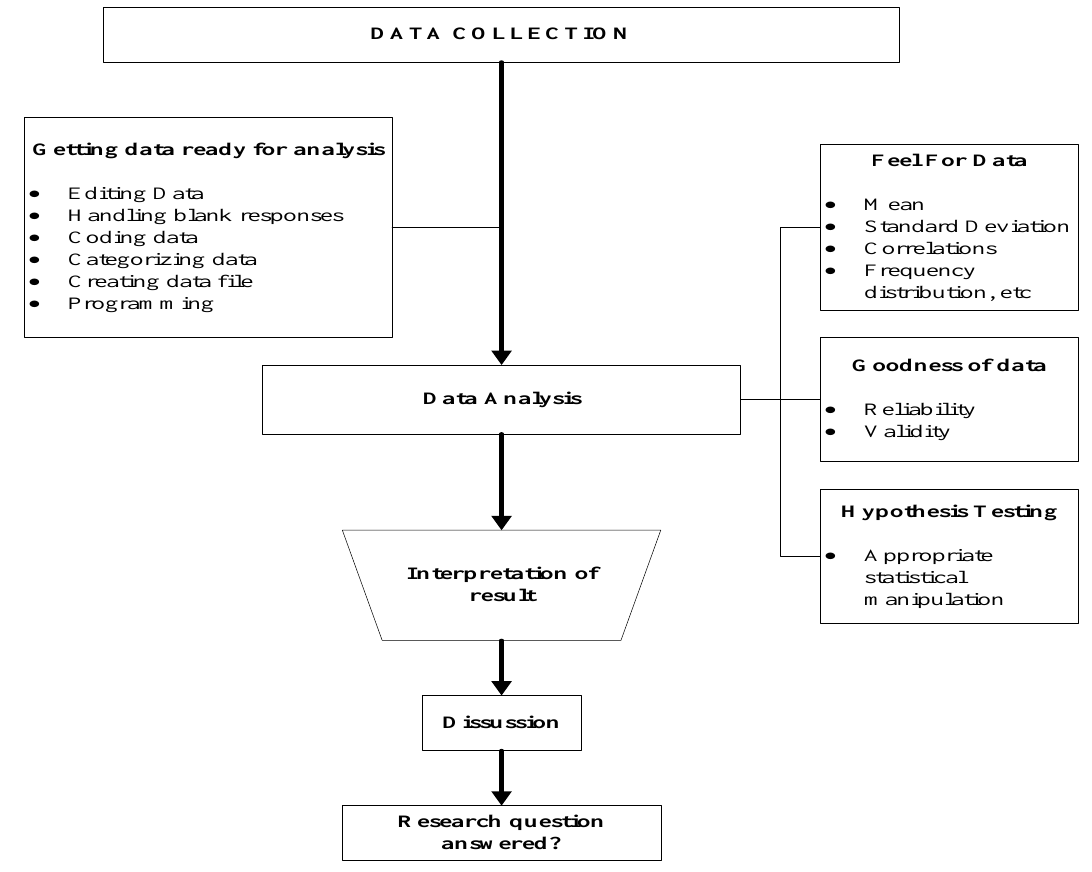
Figure 1. Data analysis flow